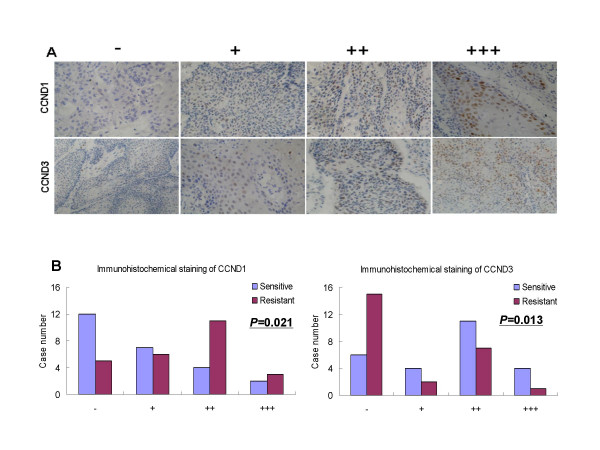
Expression of CCND1 and CCND3 in primary oral squamous cell carcinoma. Fifty specimens of primary oral squamous cell carcinoma were collected and classified into resistant (red column) and sensitive (blue column) groups on the basis of growth inhibition as assessed by the modified MTT assay, 25 cases in each group. A. Immunstaining results were ranked according to the staining percentage: '-' (0–5%), '+'(5%-20%), '++' (20%-50%) and '+++' (>50%). B. Mann-Whitney U test showed that CCND1 (P = 0.021) and CCND3 (P = 0.013) were differentially expressed in primary tumors in a manner consistent with their drug resistance patterns.